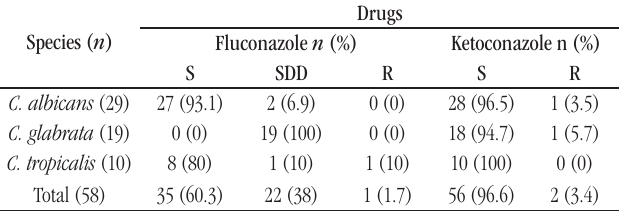
taBLE 2 − Susceptibility profile to azole antifungals in clinical vaginal isolates of Candida spp. from women of the southern Mato Grosso State, Brazil Species ( n )